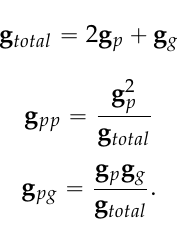
Figure 1. Star-mesh transformation for a three-phase ungrounded fault. For a line-line-ground fault, illustrated in Figure 2, a star-mesh transformation is performed in order to calculate the values of elements of G f , based on the resistances between the phases ( g p ) and the ground ( g g ),